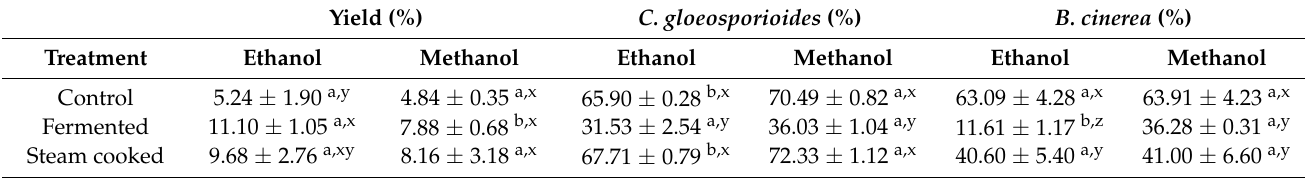
Table 2. Effect of pretreatment on the yield and antifungal activity of garlic peel extracts † . Yield (%) C. gloeosporioides (%) B. cinerea